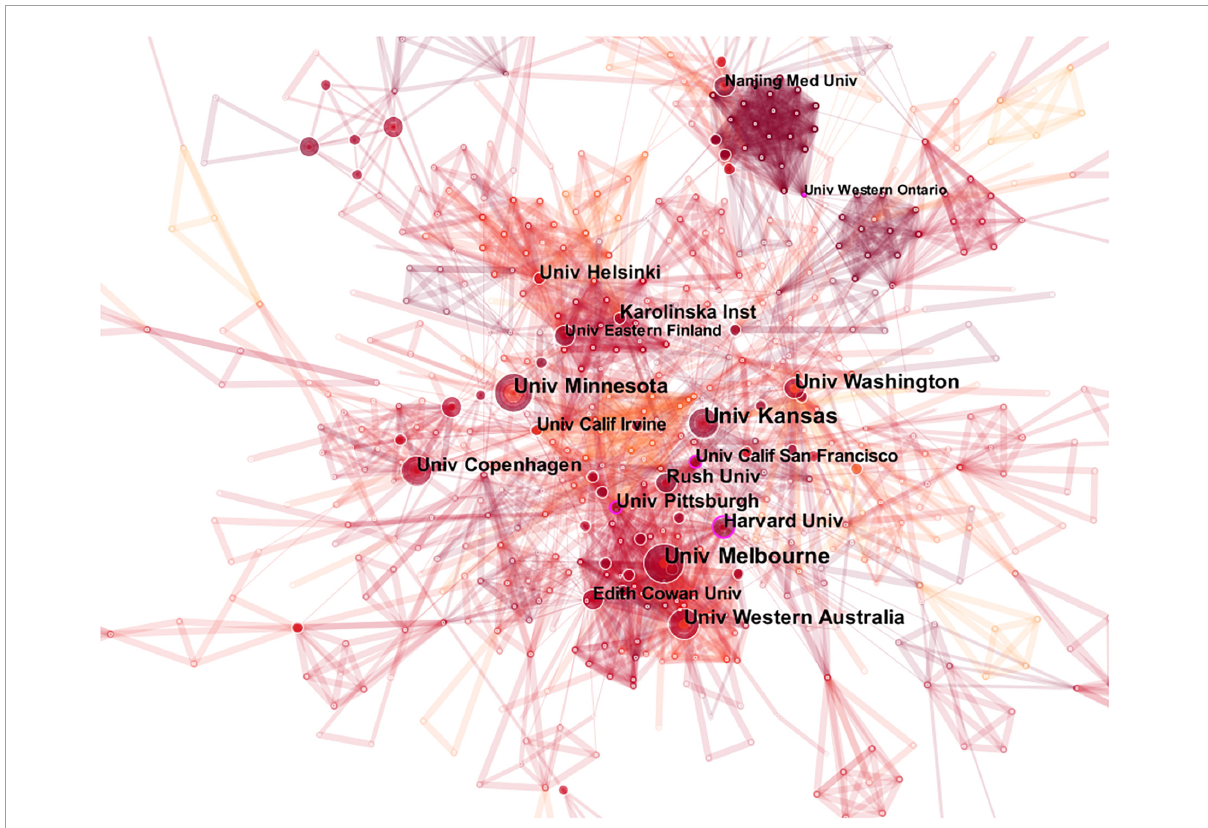
FIGURE3 The map of co-institutions. The nodes in the map represent co-institutions, and lines between the nodes represent co-citation relationships. The purple ring represents centrality.